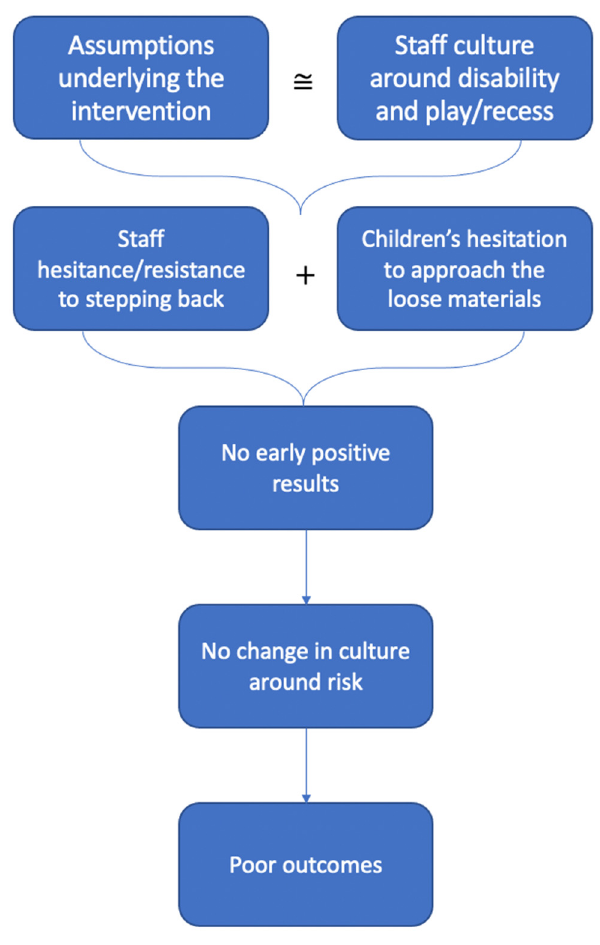
Figure 3. Proposed relationship among aspects of staff culture, assumptions underlying the inter- vention, and the intervention at School A. ≅ refers to congruence.